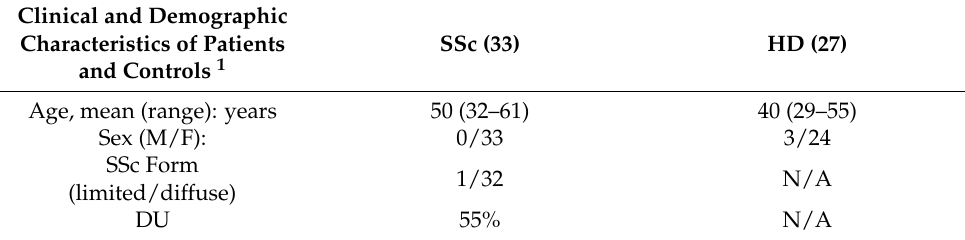
Table 1. Selected main clinical, demographic and laboratory features of SSc patients and HD. Clinical and